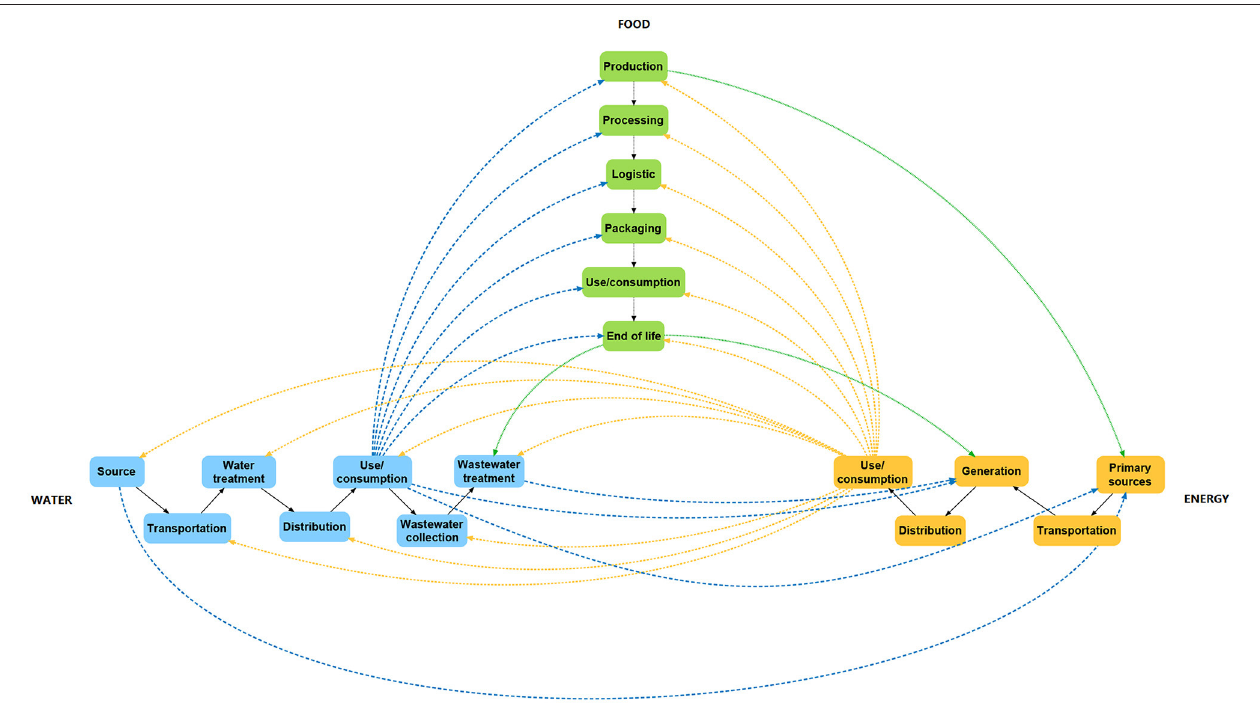
FIGURE 1 | Interactions between water, energy, and food value